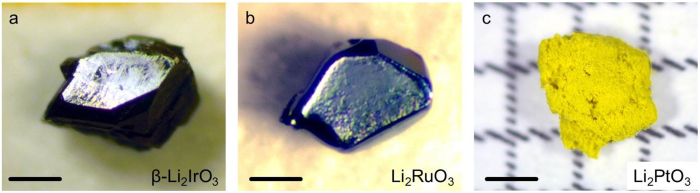
Further materials synthesized from separated educts.(a) β-Li2IrO3 single crystal (scale bar 0.2 mm) and (b) a single crystal of Li2RuO3 (scale bar 0.1 mm). For Li2PtO3 fine yellow powder could be obtained shown in (c) (scale bar 1 mm).